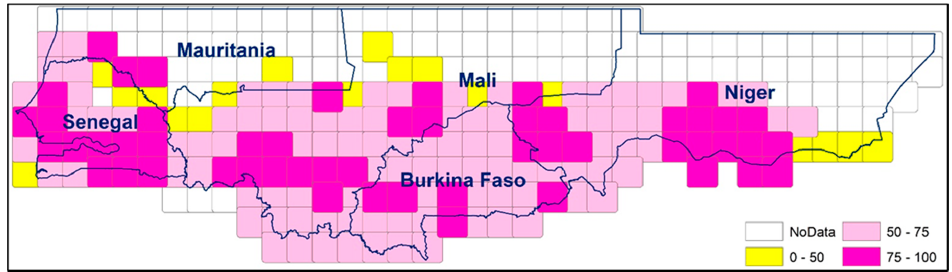
Figure A3. Crop User’s accuracy at grid level.